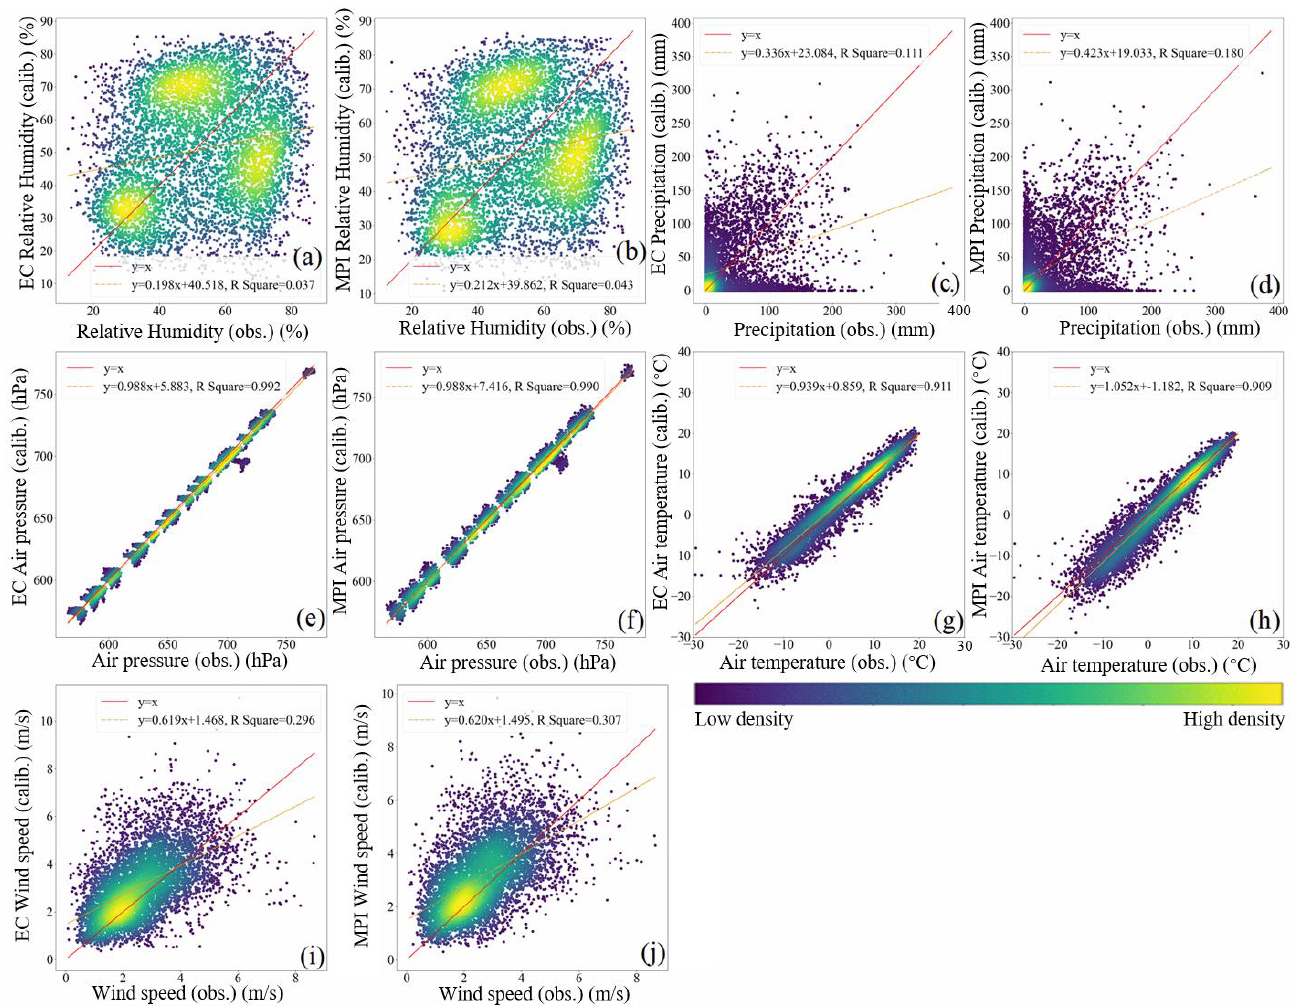
Figure 11. Calibrated results (the ordinates) by the Q-M method and the corresponding monthly observations (the abscissae) of five major meteorological variables at the 36 QTP sites in the first adjustment (projection period being 1985 – 1999). The symbolic notations are the same as in Figure 3. Subplots ( a , c , e , g , i ) show the results from EC GCM simulations; and ( b , d , f , h , j ) those of the MPI GCM simulations.